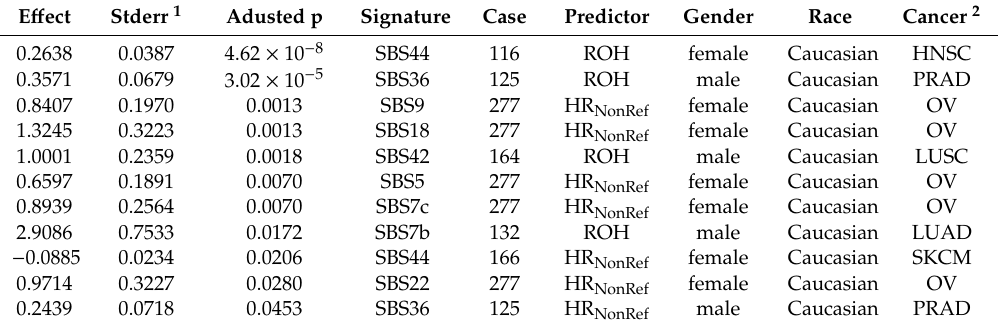
Table 3. Association between global autozygosity and mutational signatures.